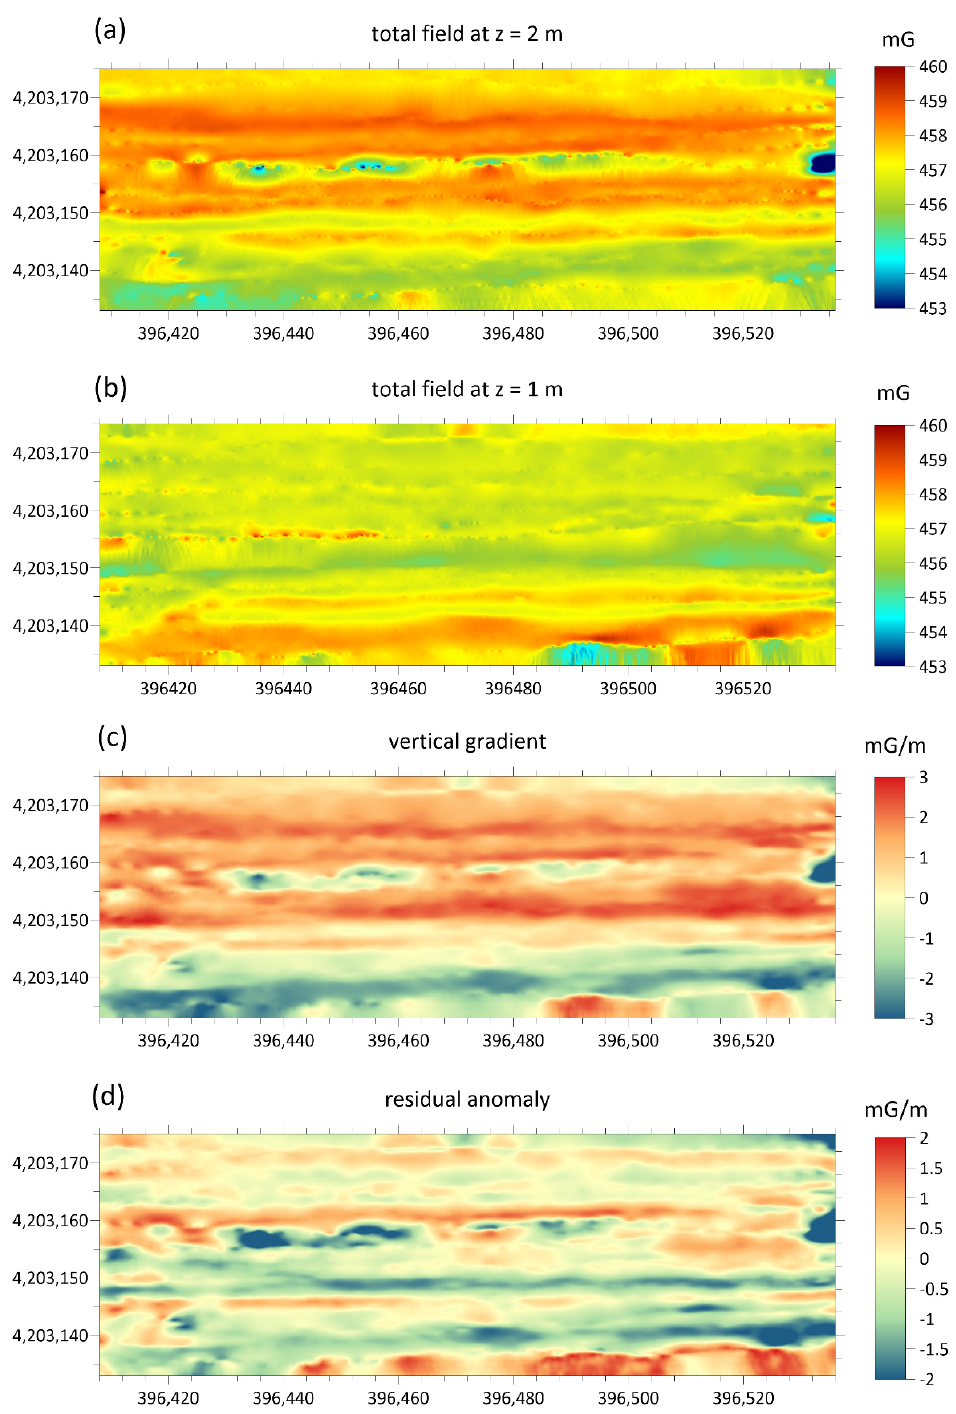
Figure 7. Steps for the calculations of the residual gradiometric anomaly related to the area covered by the first test. ( a , b ) Maps of the total magnetic field surveyed with the sensor at 3 and 2 m above ground level, respectively; ( c ) gradiometric maps resulting from the differences between the two maps; ( d ) residual anomaly after removing the background magnetic signal. Projected coordinates referred to UTM zone 33. Units of the magnetic field are in milligauss.